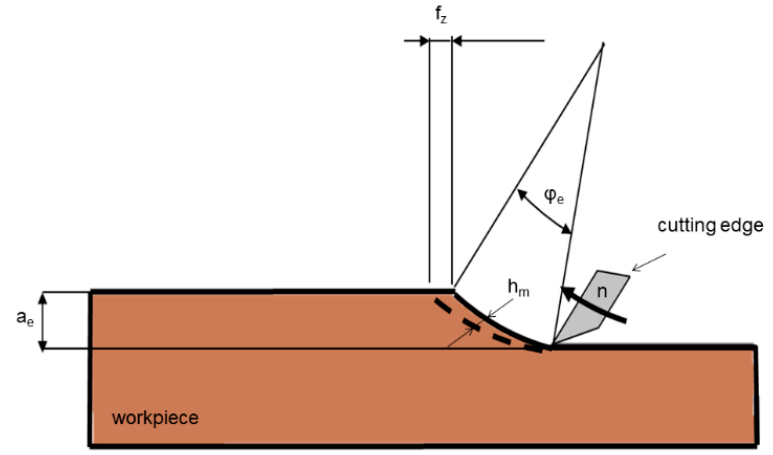
Figure 6. Schematic presentation of the parameters required for the calculation of chip thickness h m (Equations (3) and (4)) and chip arc length s b (Equation (5)).